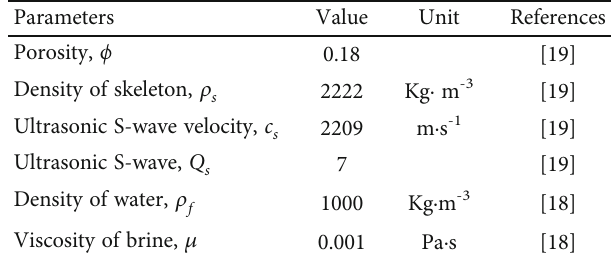
Table 1: Parameters of water-saturated limestone under di ff erential pressure of 3 MPa.